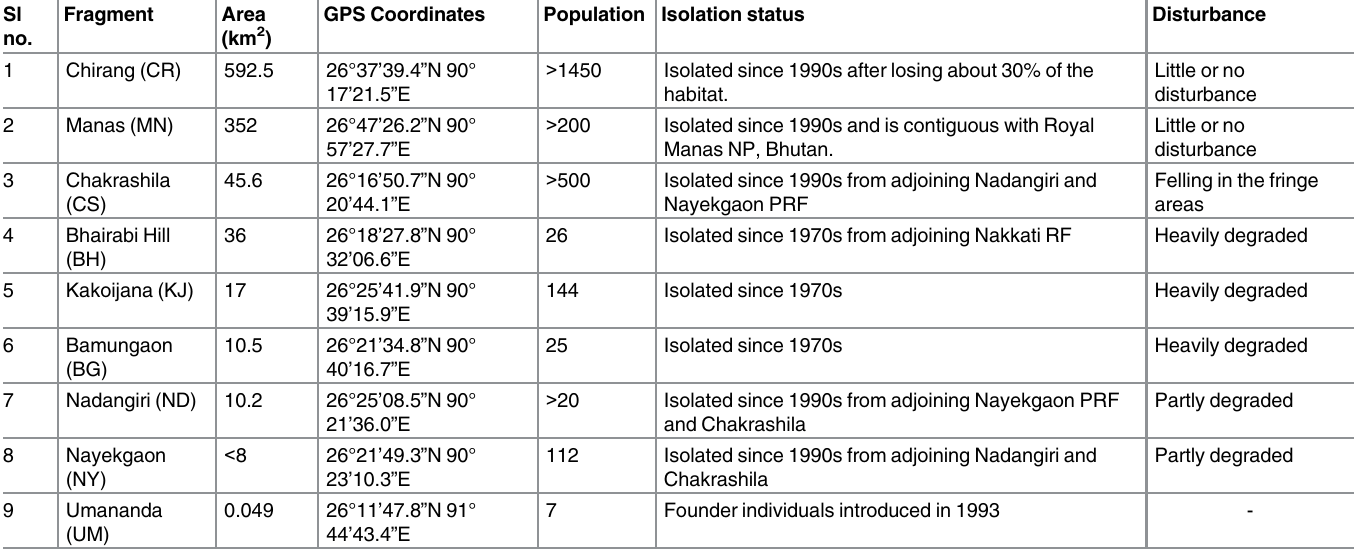
Table 1. Study sites and their isolation